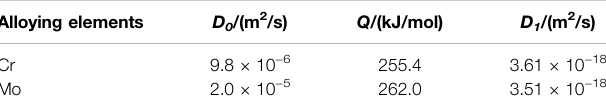
TABLE 3 | Frequency factor D 0 , diffusion activation energy Q and diffusion coef fi cient D 1 of Cr and Mo atoms in FCC-Co at 1073 K (Neumeier et al., 2016).